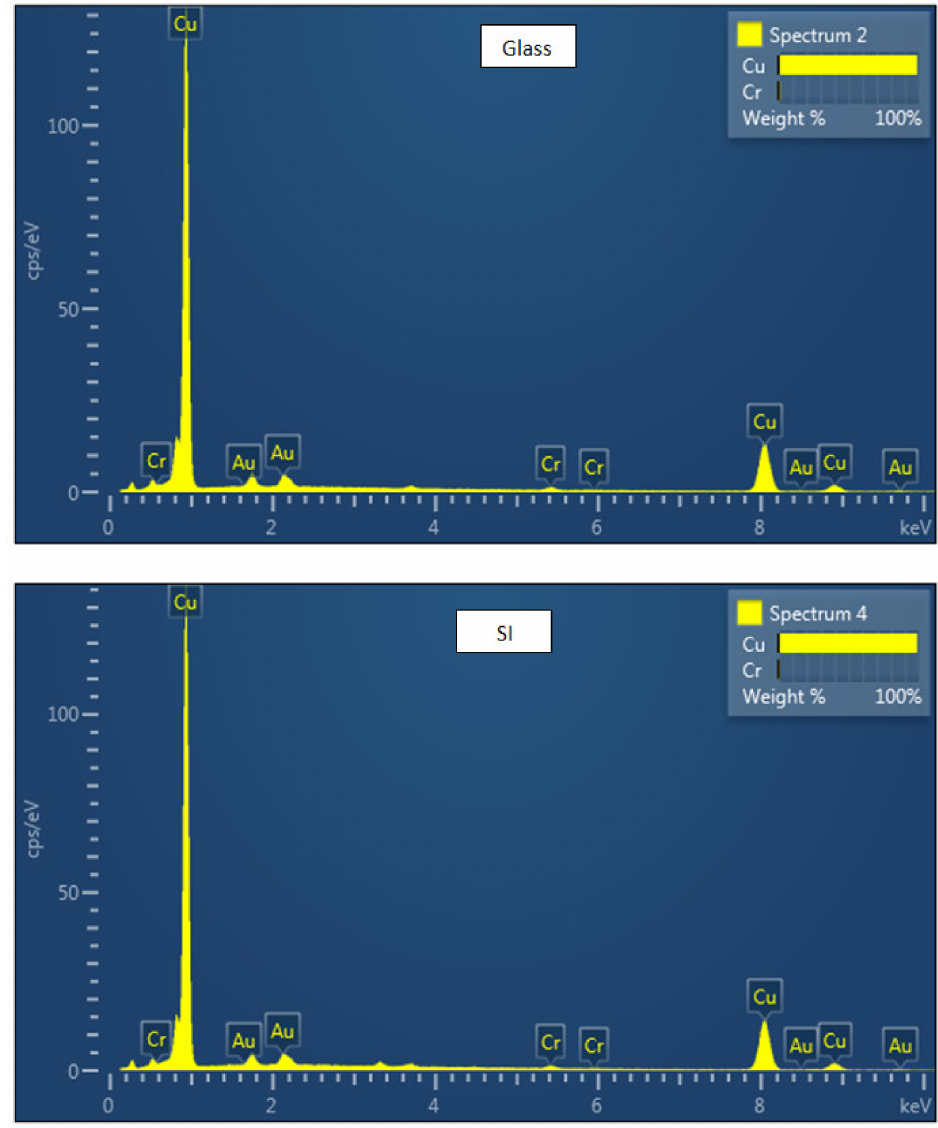
Figure 2. EDS spectra signifying the formation of Cu/Cr thin films on Glass and Si